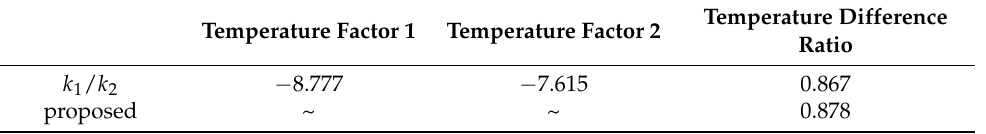
Table 2. Calculated temperature difference ratio through the two method.